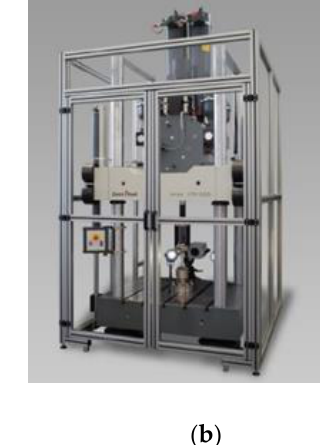
Figure 2. Tensile test machines: ( a ) electronic universal testing machine; ( b ) large dynamic testing machine. Table 1. Tensile test matrix used in this study.